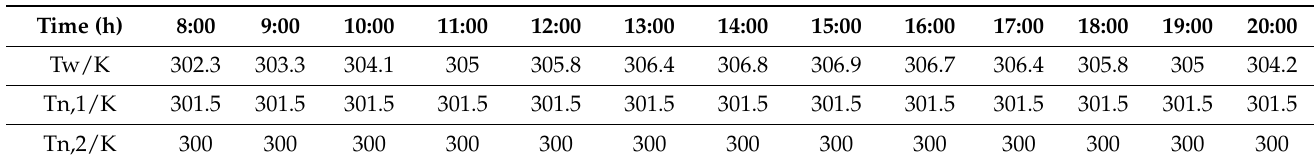
Table 4. Hourly temperature inside and outside the subway carriage under representative summer weather